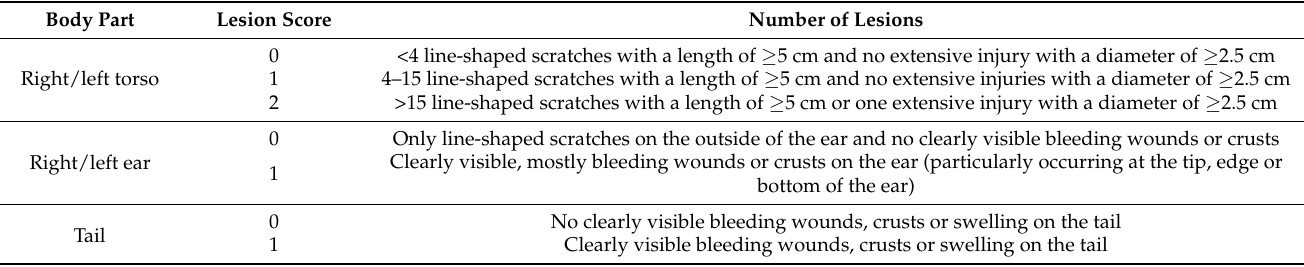
Table 1. Lesions score assessment carried out for every pig after Schrader et al. [35]. Body Part Lesion Score Number of Lesions Right/left